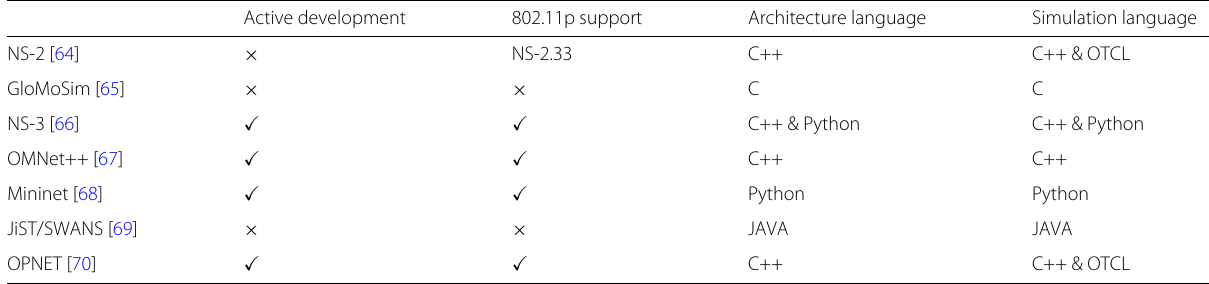
Table 2 Network simulators Active development 802.11p support Architecture language Simulation